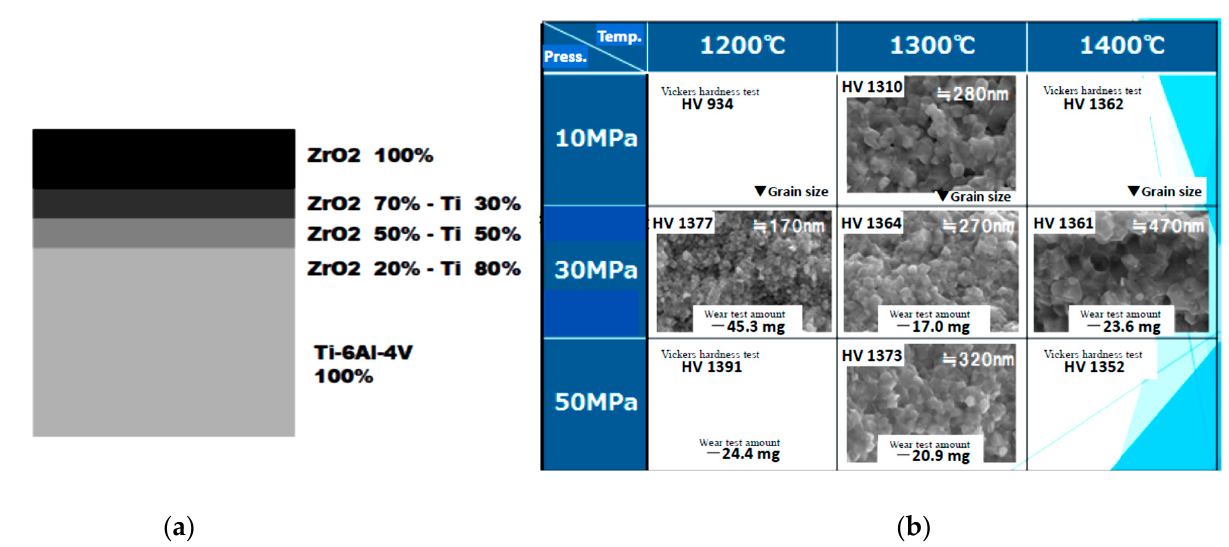
Figure 41. ( a ) ZrO2/Ti alloy system FGMs profile and ( b ) Relationship between sintering pressure and temperature on 100%ZrO 2